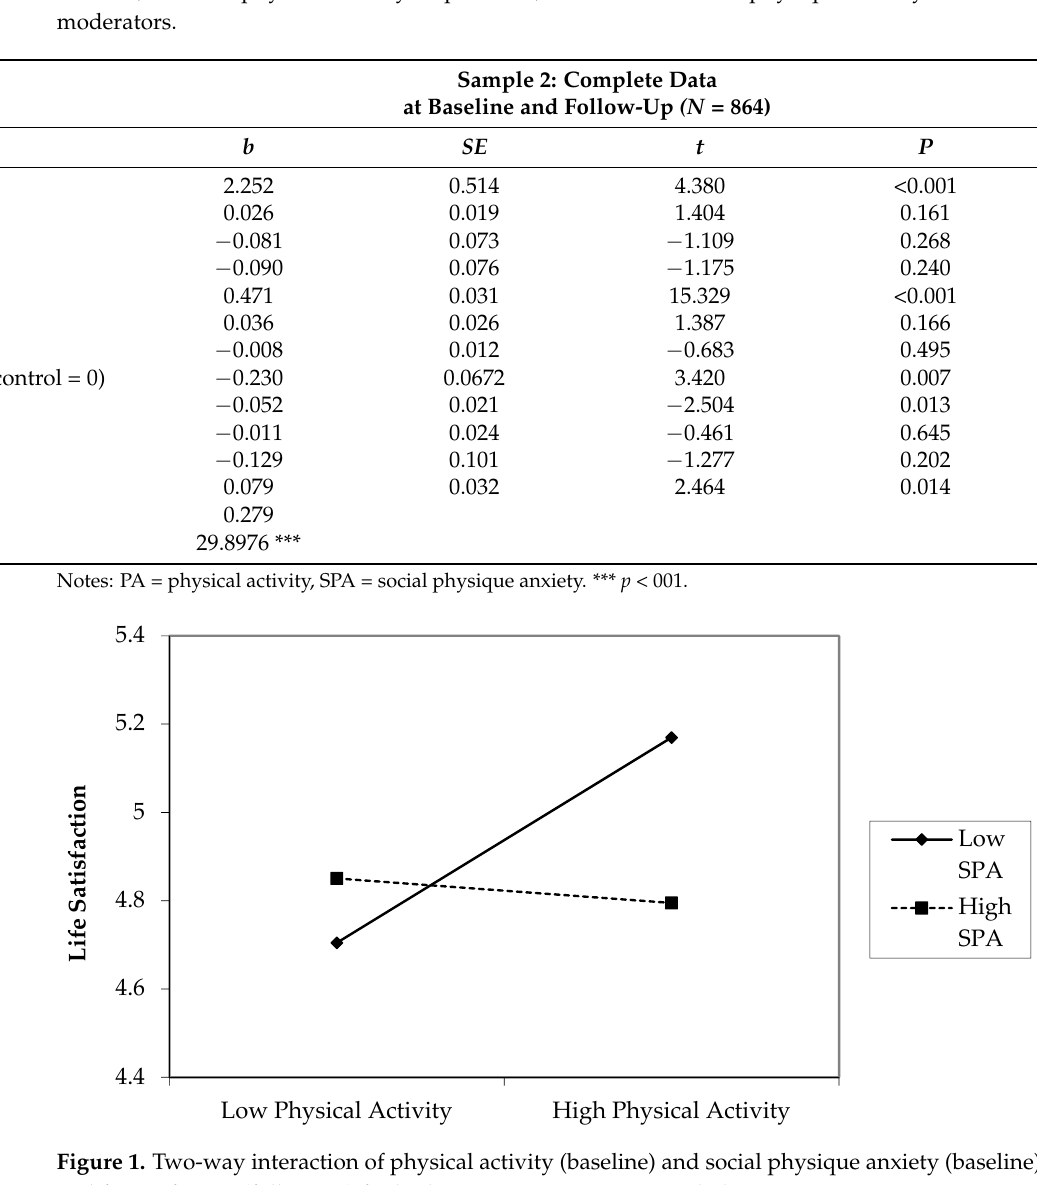
Table 4. Longitudinal conditional process model with life satisfaction at follow-up as dependent variable, baseline physical activity as predictor, and baseline social physique anxiety and sex as moderators.